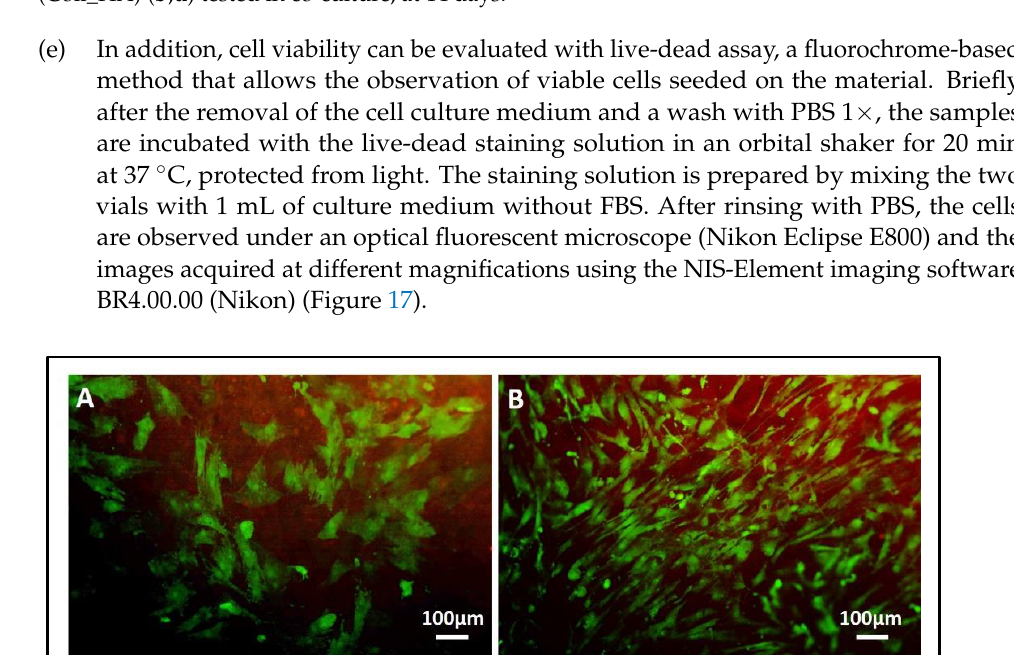
Figure 16. Scanning electron micrographs of human osteoblasts ( a , b ) and PBMCs ( c , d ) on collagen- based scaffolds containing mesoporous bioactive glasses (Coll_MBG) ( a , c ) and nano-hydroxyapatite (Coll_HA) ( b , d ) tested in co-culture, at 14 days.